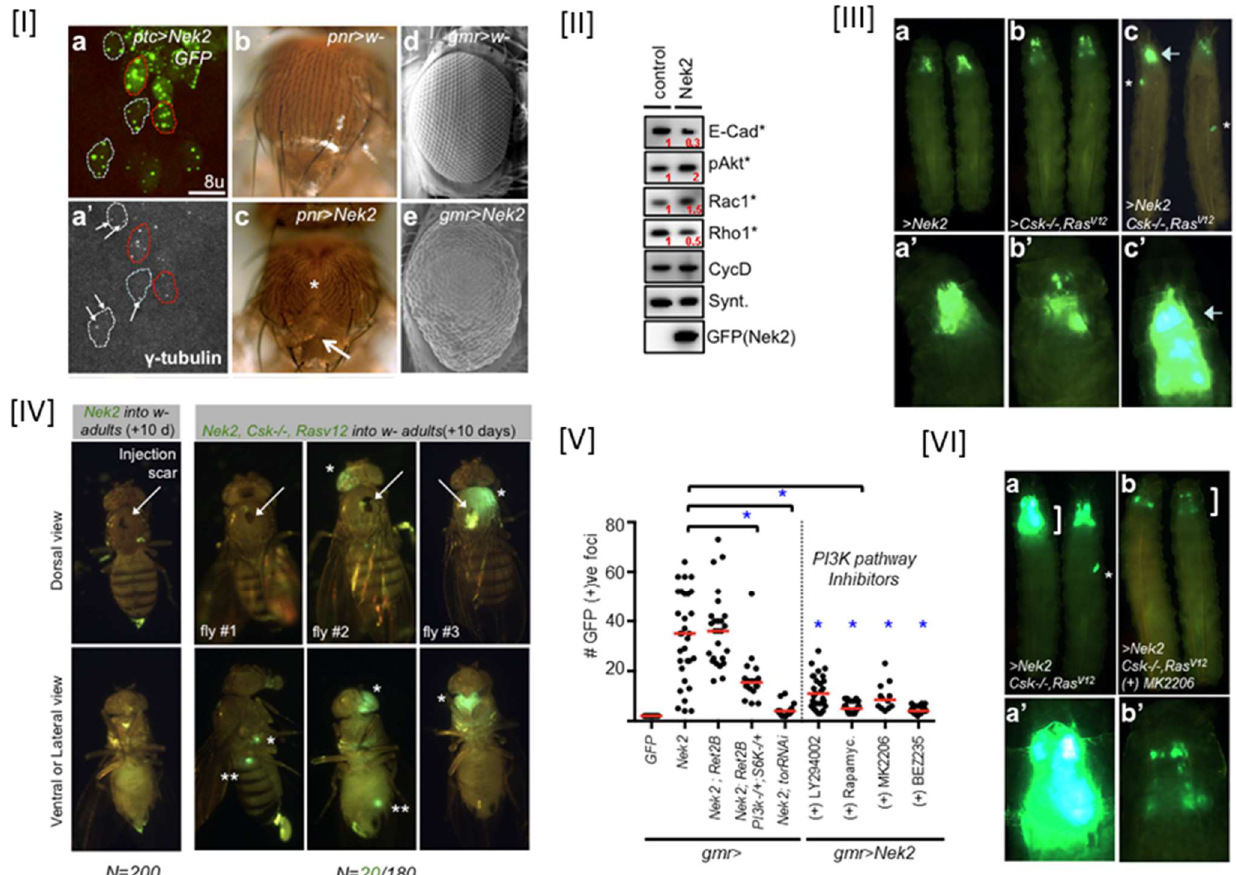
Figure 5. Development of Nek2 overexpression model in Drosophila melanogaster , its phenotypical evaluation, and utilization in studying signaling pathways: [ I ] (a and a’) Overabundance of dNek2 leads to centrosome amplification, as visualized by centrosomal marker γ tubulin (red circle, single white arrow). (c) Nek2 overexpression in thorax, driven by pnr promoter, results in defective notum and scutellum (asterisk), compared to wt flies, as in b. (e) Nek2 overexpression in eyes driven by gmr promoter results in patterning defects, compared to wt flies, as in d. [ II ] Western blot analysis suggests that, upon Nek2 overexpression, (i) key markers of cell migration pathway are dysregulated and (ii) PI3K/Akt pathway is activated. [ III ] (c) Co-expression of Nek2 kinase with oncogenic Ras (Csk−/−, Ras V [12]) promotes primary tumor mass increase and distant cell seeding phenotype (asterisk), compared to Nek2 kinase alone as in a and oncogenic Ras alone as in b (eye-FLP-MARCM experiment). [IV] Tumor cell injection assay indicates the close cooperation of Nek2 kinase signaling with oncogenic Ras to promote migration of primary tumor foci away from the tumor injection site (asterisks), compared to control (Nek2 in w-adults). [ V , VI ] Genetic and pharmacological inhibition of PI3K pathway significantly reduces cell seeding phenotypes in Nek2 overexpression flies, as well as primary tumor growth in b, compared to control a. [Adopted from Das et al., Oncogenesis 2013, 2, e69, with permission].